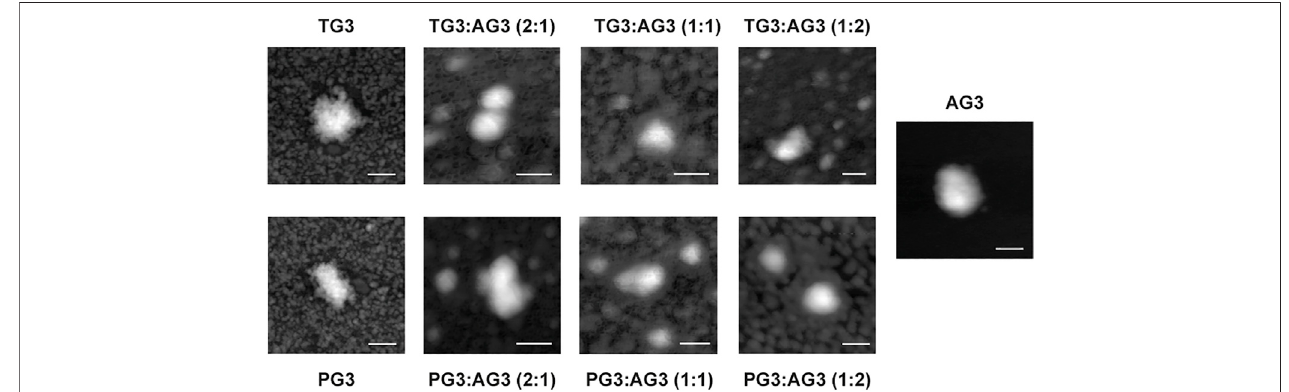
FIGURE 2 | Representative AFM images of dendriplexes. Charge ratio 5. Scale bar is 100 nm.